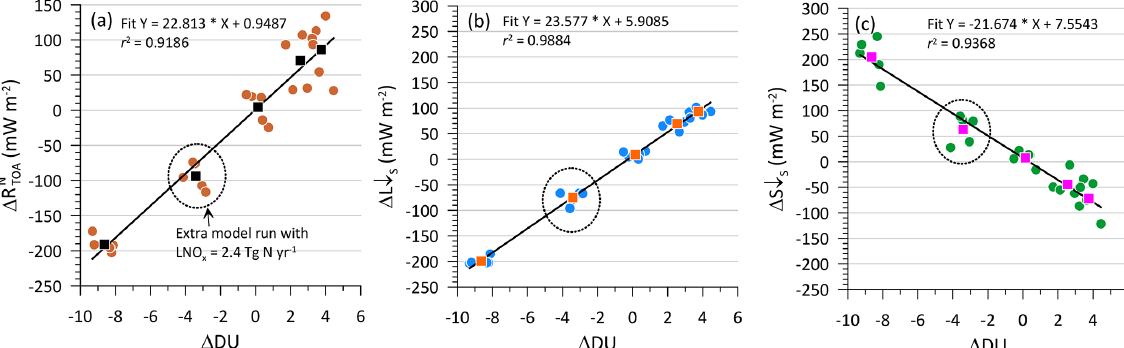
), (b) incoming surface longwave radiation ( (cid:49)L ↓ S ), and Figure 9. Change in the modelled (a) net downward total TOA radiation ( (cid:49)R N TOA (c) incoming surface shortwave radiation ( (cid:49)S ↓ S ), as a function of change in the modelled O 3 column ( (cid:49) DU) relative to the base model run. All runs except Run E (i.e. without the CH 4 radiation feedback) are considered. Results from an additional model simulation the same as Run C but with averaged LNO x = 2 . 4TgNyr − 1 are also plotted (enclosed in a dotted circle) to check linearity. The solid circles are the annual means, whereas the squares are the mean over 2006–2010. The best fit line is based on all